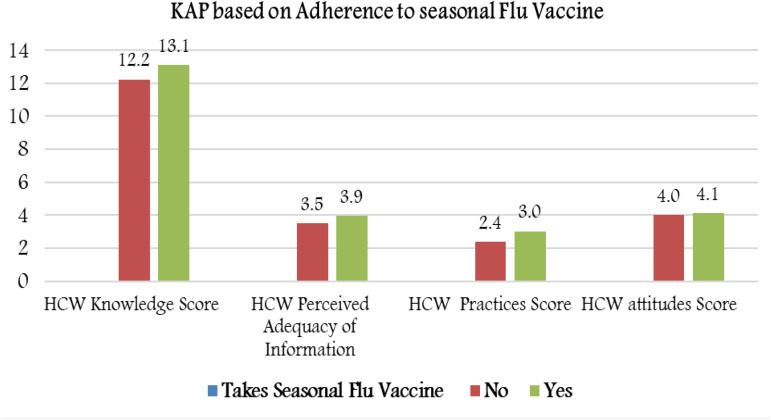
Mean KAP scores based on adherence to seasonal flu vaccinations.